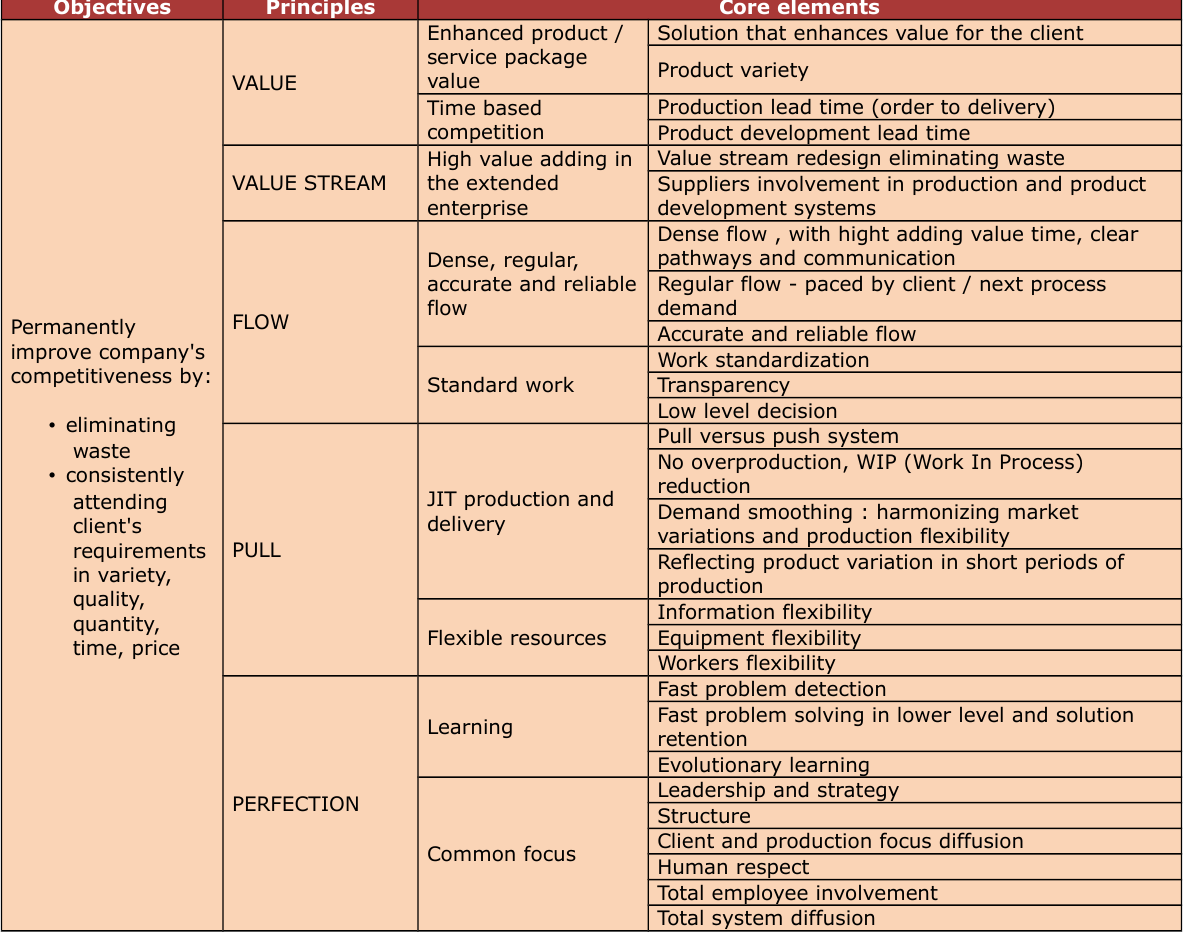
Table 2. Lean Principles core elements (Picchi,